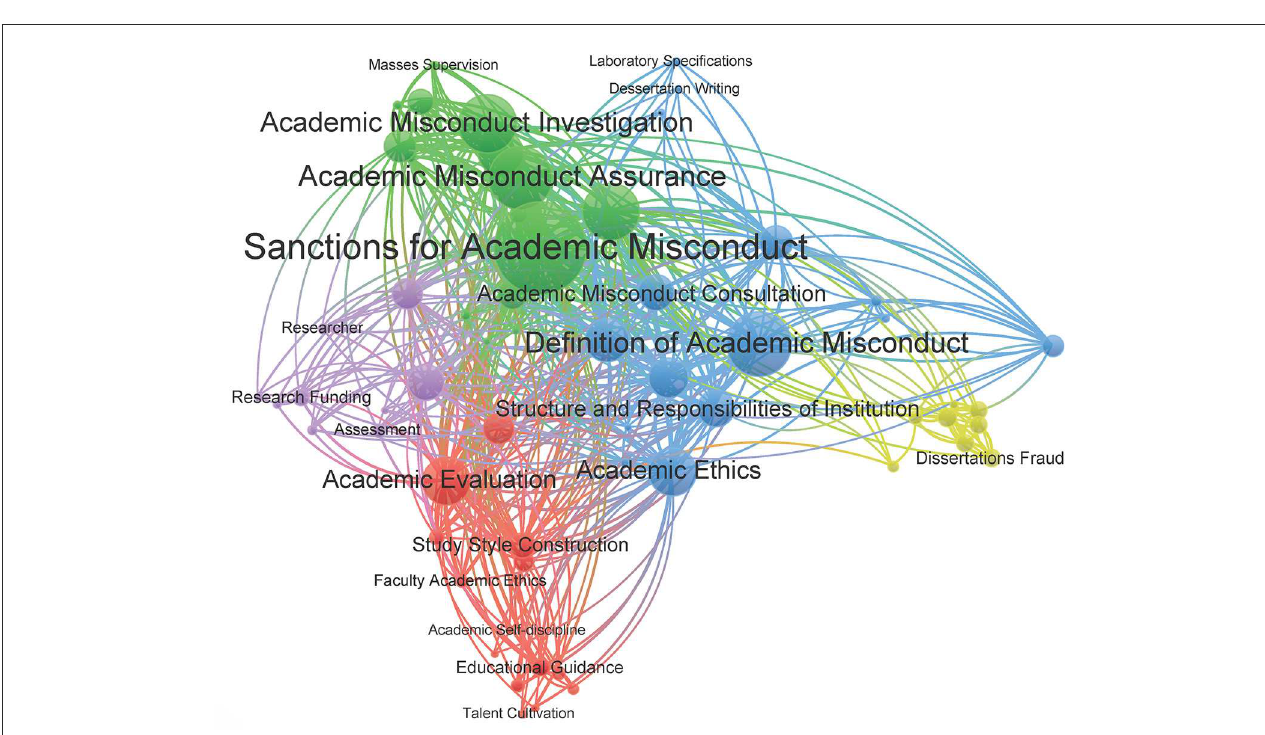
FIGURE4 Cluster relation of the keywords of university RI